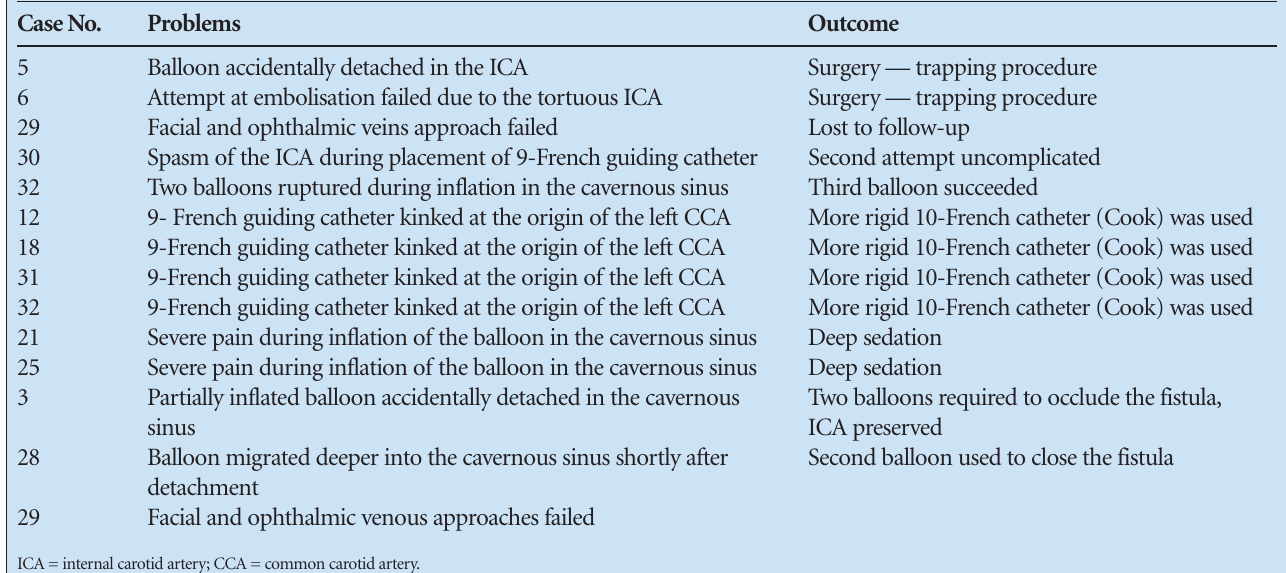
Table V. Technical problems during embolisation (grouped by type of problem) Case No.